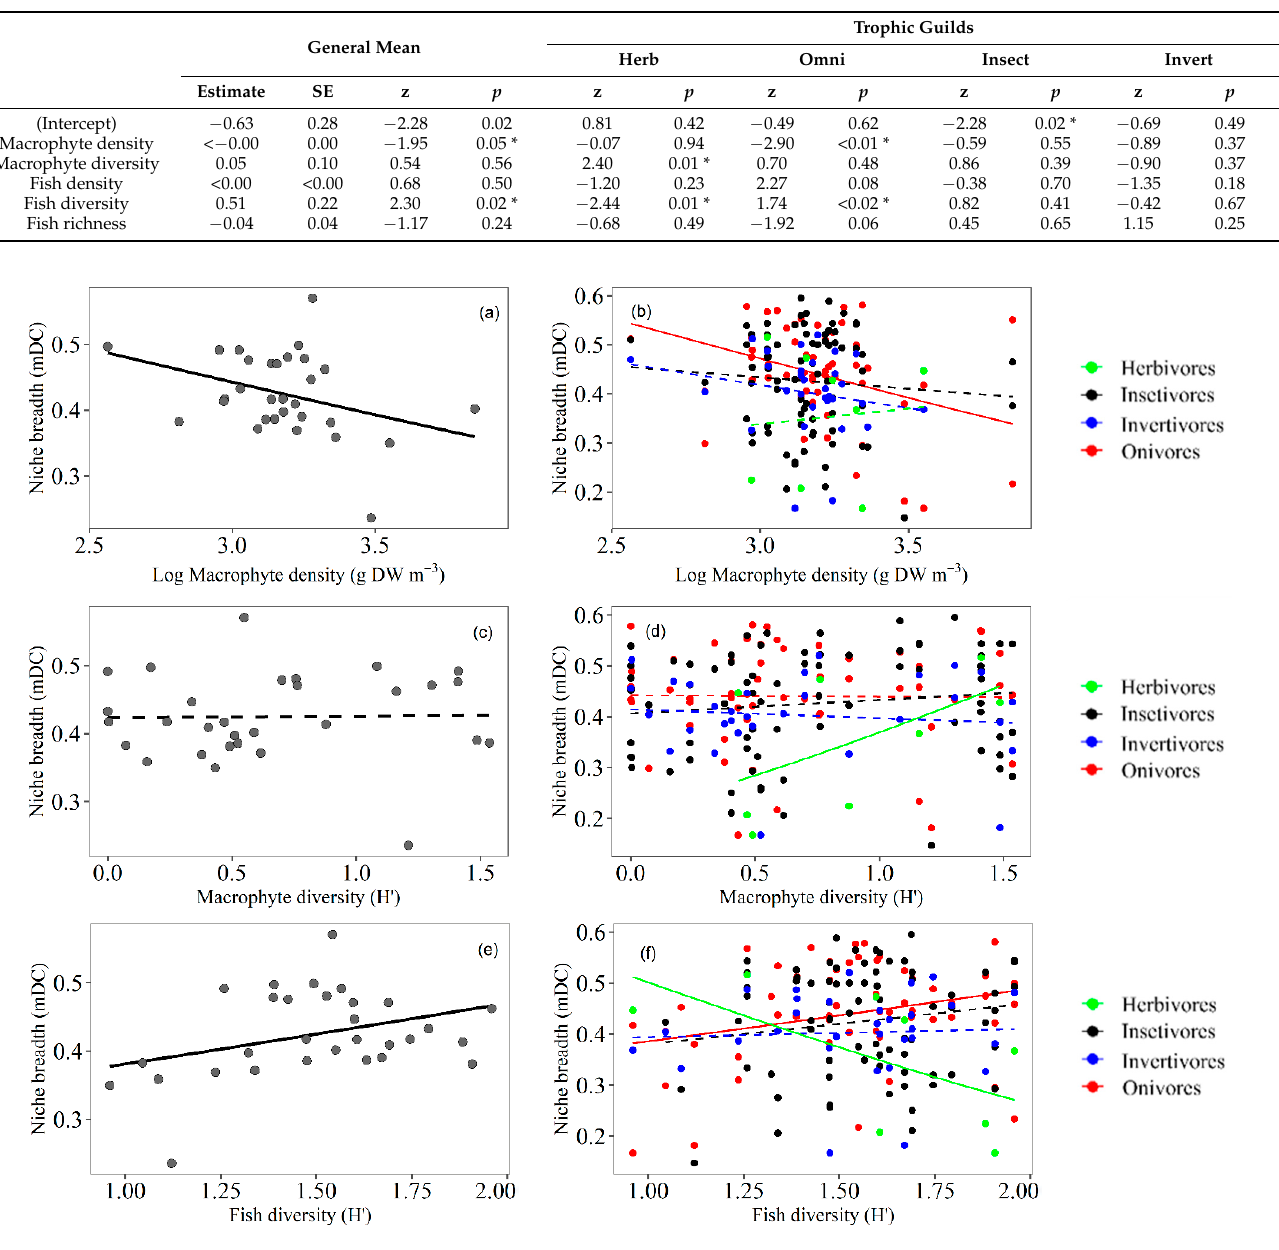
Table 3. Results of beta regression analysis for the trophic niche breadth assessed by the mean distance from the centroid (mDC) considering a general mean and a mean calculated for each trophic guild separately. Herb = herbivores; Omni= omnivores; Insect = insectivores; Invert = invertivores. * = statistically significant values.